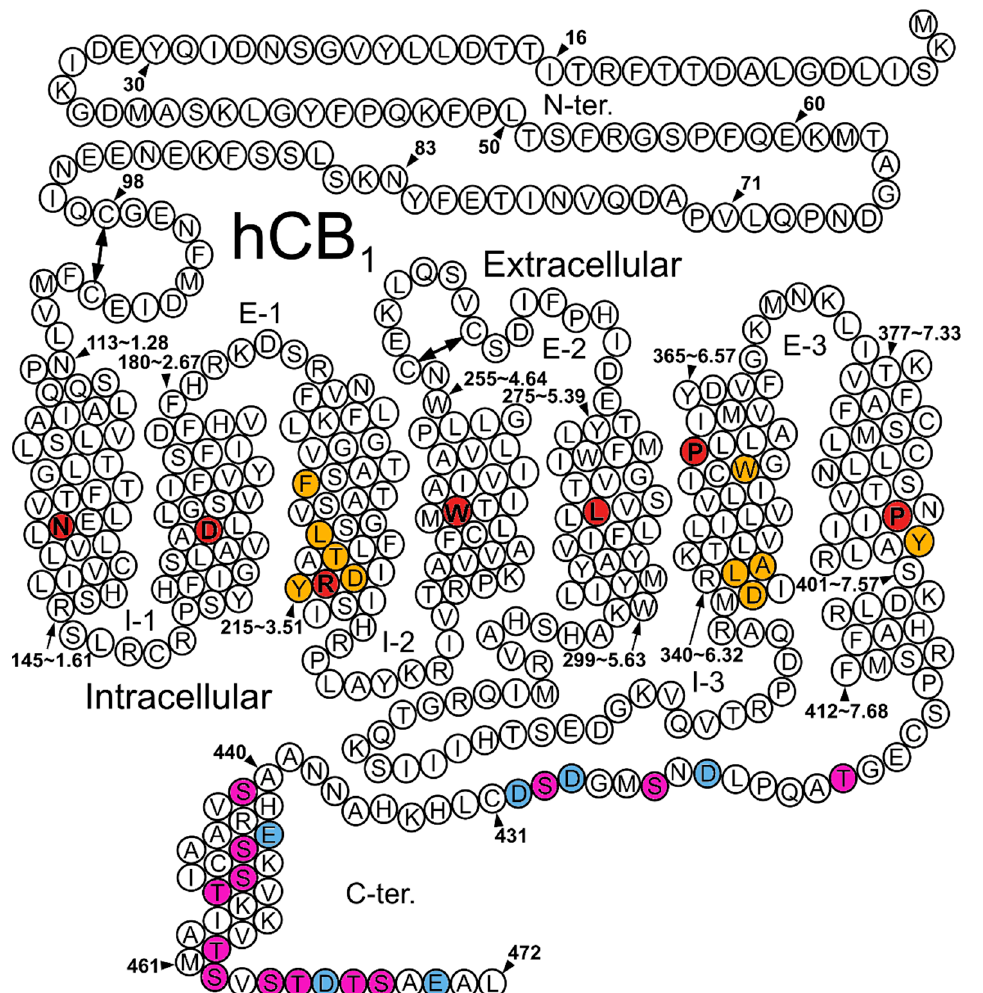
Figure 1. Human CB1 Helix net. (I1–I3 for the intracellular (IC) loops, E1–E3 for the extracellular (EC) loops). The most conserved amino acid residue in each helix in red. Purple highlights for putative phosphorylation sites on the C-terminus of the receptor. Blue highlights for negatively-charged residues in the C-terminus. Other residues discussed are highlighted in orange; in order, they are: F3.36, L3.43, T3.46, Y3.49, D3.51, W6.48, L341(6.33), A342(6.34), D6.30, and Y7.53.